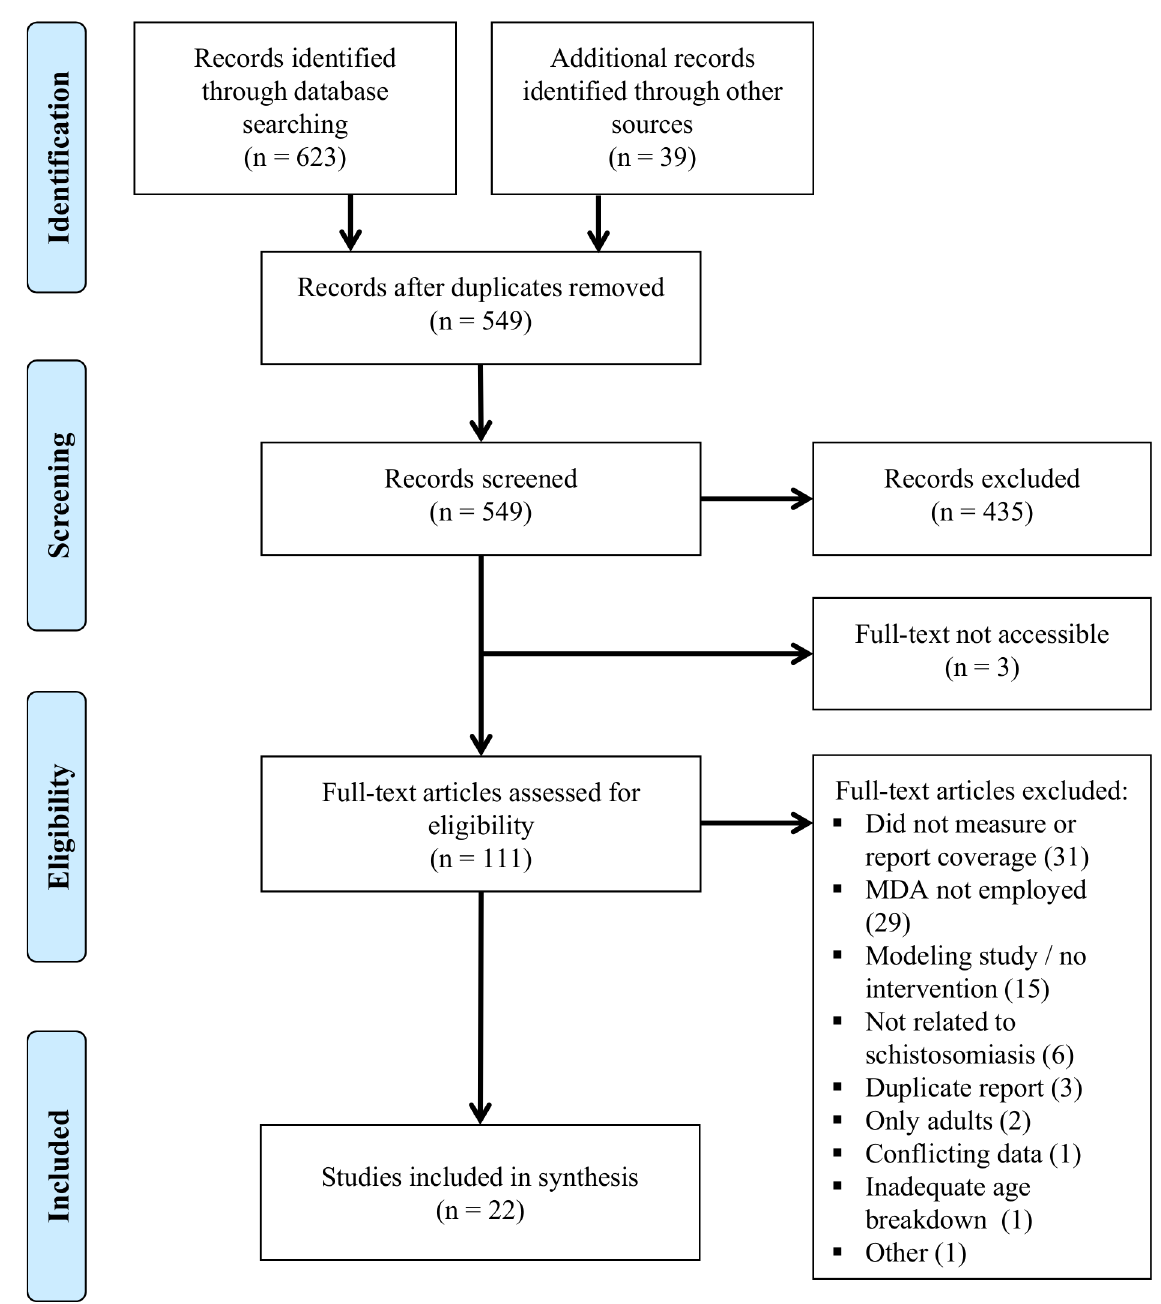
Fig 1. Flow chart for study selection. The flow diagramindicatesthe numbersof titles and studies reviewedin preparation of the current systematic review of treatment coverageeffects of different approaches to MDA for schistosomiasis.